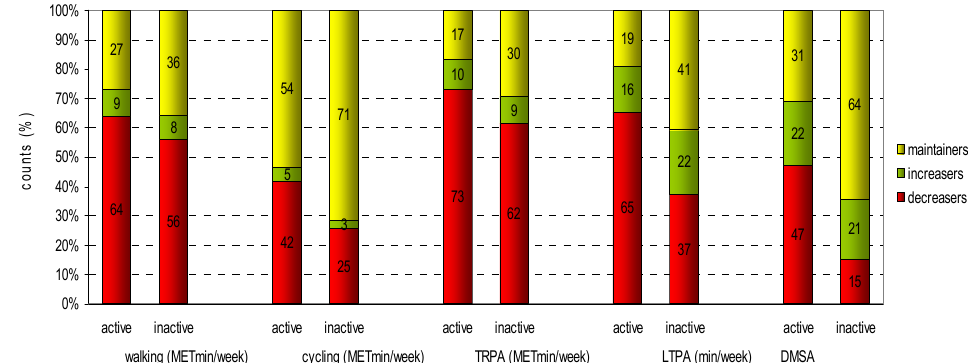
Figure 1. Counts (%) changes from normal to lockdown in the active and the inactive subsample. Binary logistic regressions were computed for the explanation of compliance with WHO PA recommendations using demographic data (sex: male vs. female, age, and BMI) as well as activity data (WRPA, TRPA, LTPA, and DMSA) and the categorical variable “lockdown vs. normal” condition. Due to missing demographic data ( n = 11), 1489 datasets were